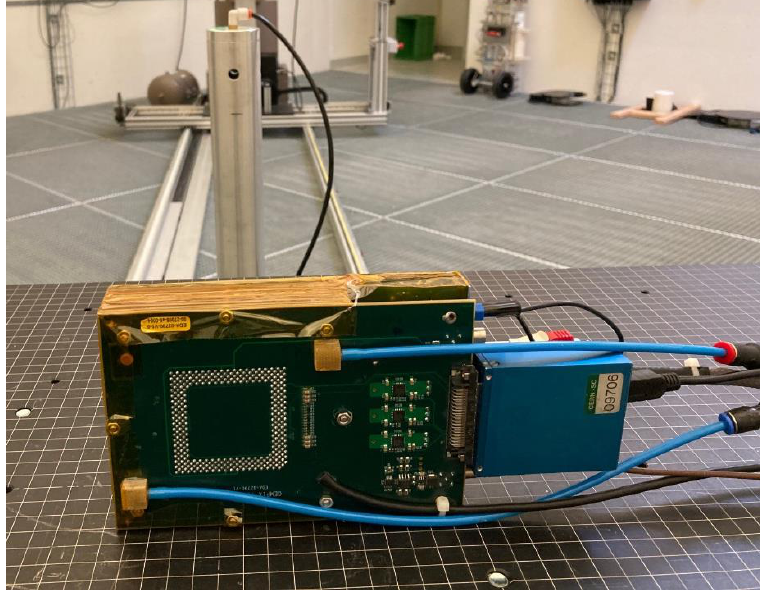
Figure 13. The GEMPix detector (foreground) set up for measurements with an AmBe source (the metal cylinder housing the source is visible in the background).